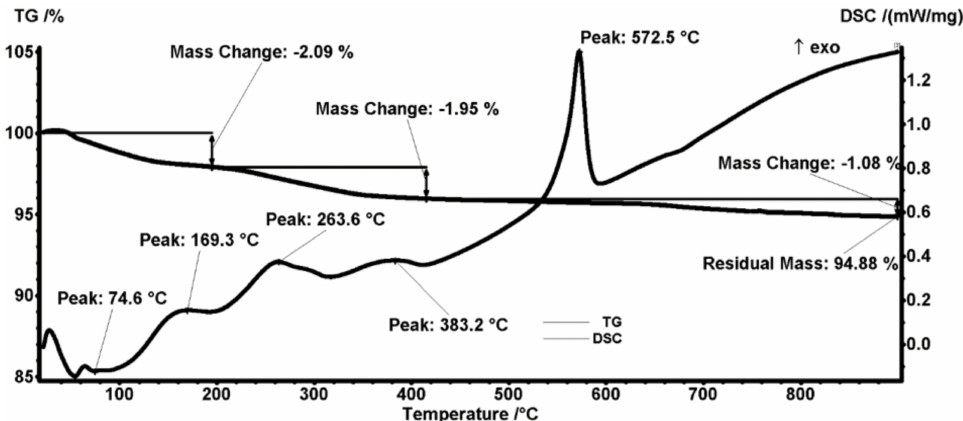
Figure 5. Thermogravimetric analysis of Fe 3 O 4 @PEG